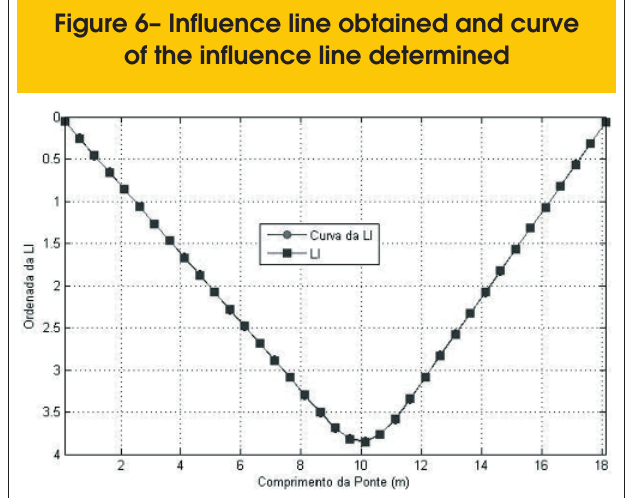
Figure 6– Influence line obtained and curve of the influence line determined